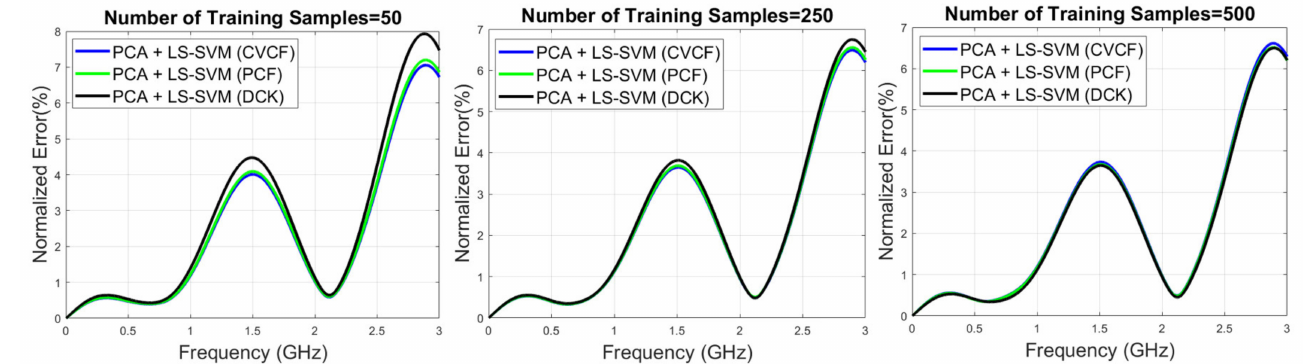
Figure 4. Comparison of the relative NRMSE values computed by the proposed approaches on the test samples by considering the imaginary part of the S21 parameter of the serpentine delay line structure for an increasing number of training samples (i.e., L = 50, 250, 500).